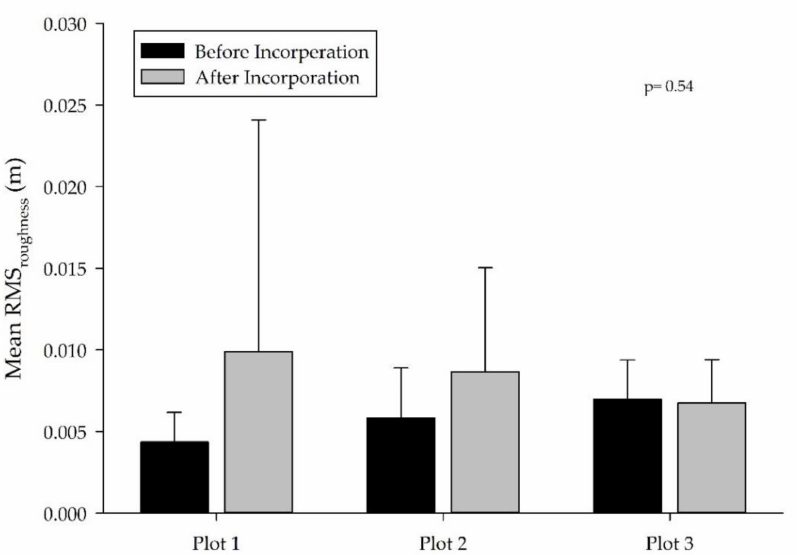
Figure 7. Arithmetic mean RMS roughness (m) of the measured profile before and after the incorporation of the nonwoven. n = 14. The measurement was performed by a long-range sensor. The error bar is the standard deviation. The p -value shows the paired Tukey test for mean RMS roughness before and after the incorporation calculated for all three